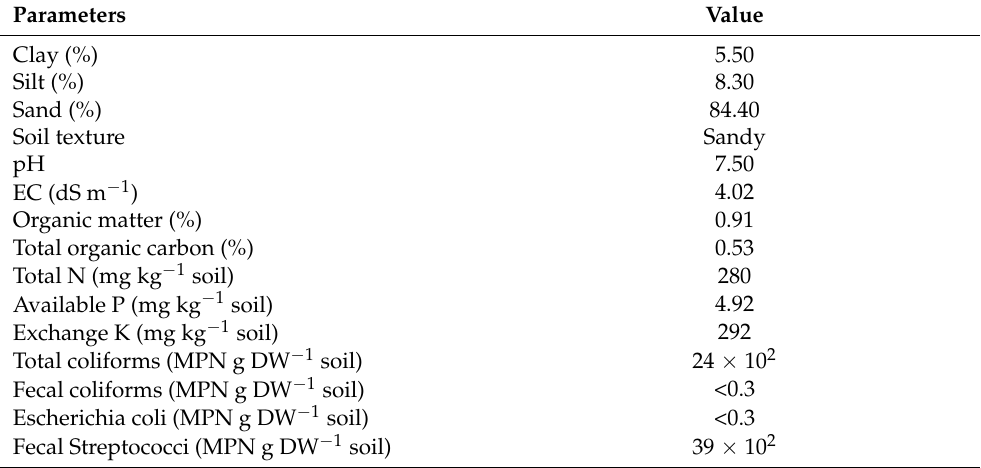
Table 1. Soil physiochemical